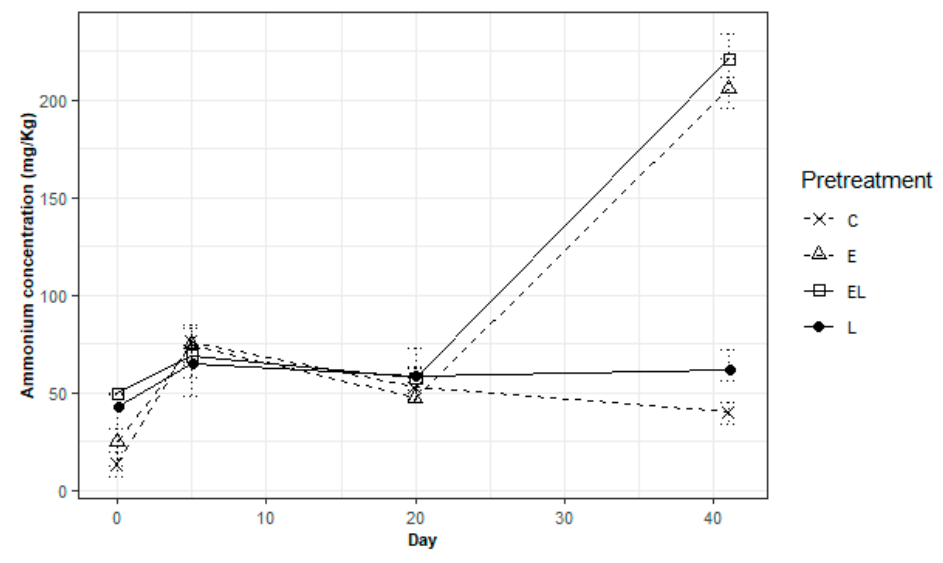
Figure 3. Ammonium concentration in soil (Pretreatment).